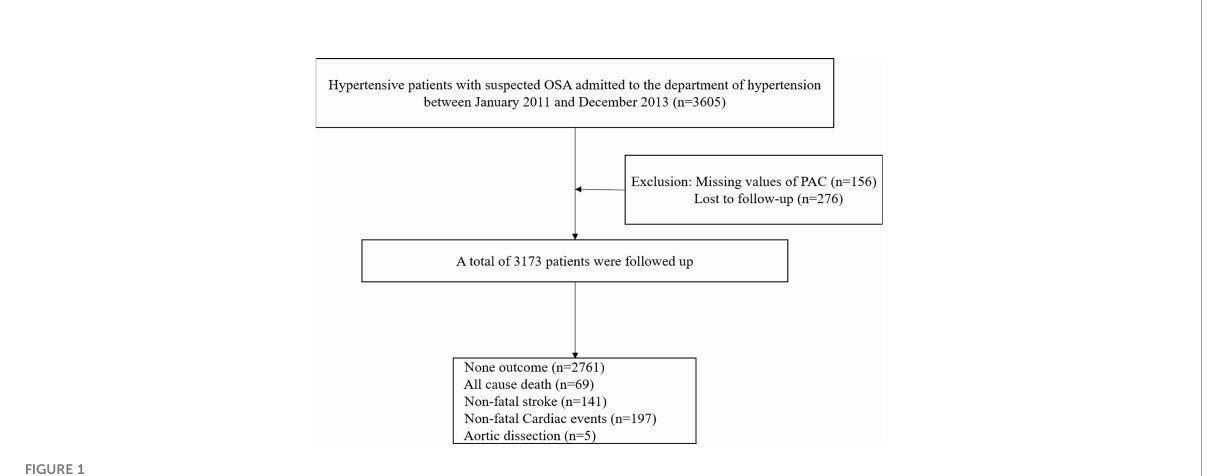
FIGURE 1 Flowchart of participants for this